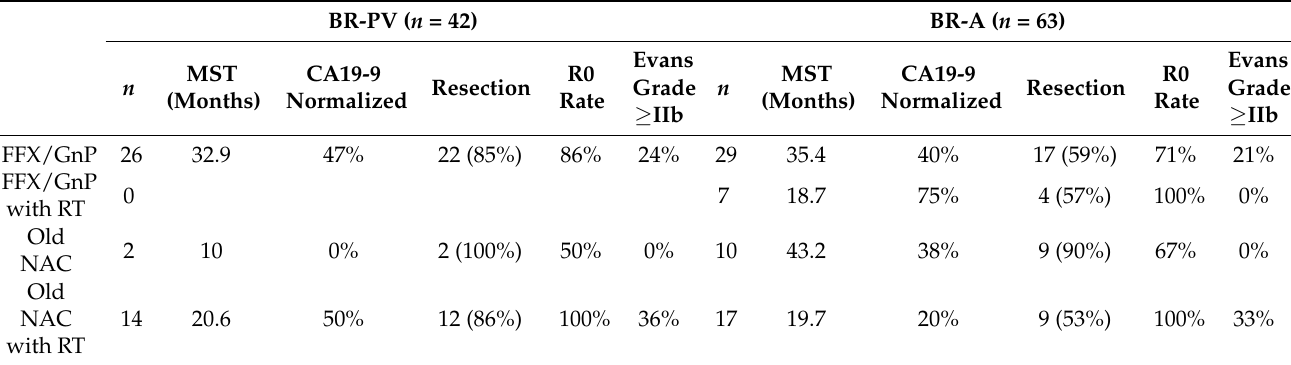
Table 4. Comparison of regimens in patients who underwent